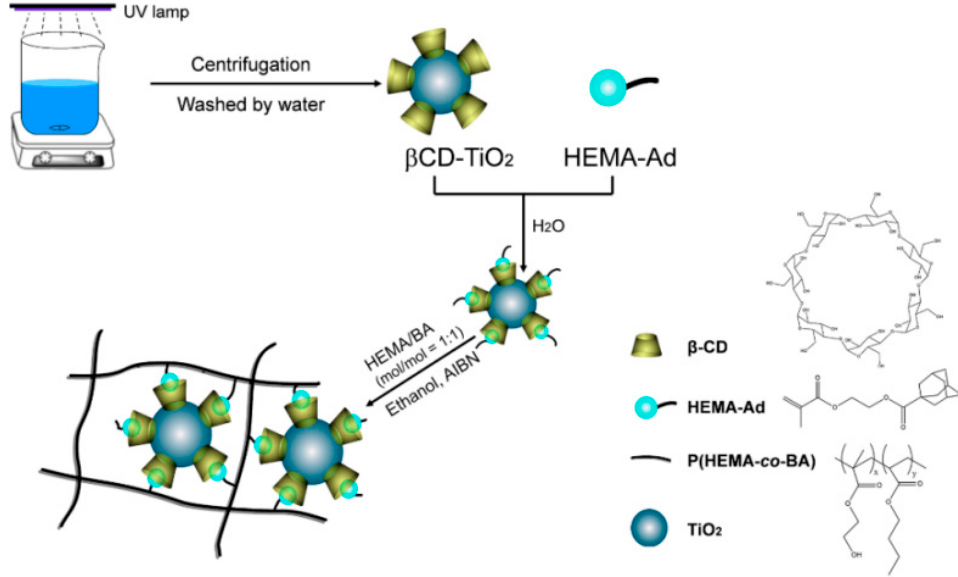
Figure 2. Schematic of the preparation process of β -CD-TiO 2 /P(HEMA-co-BA).